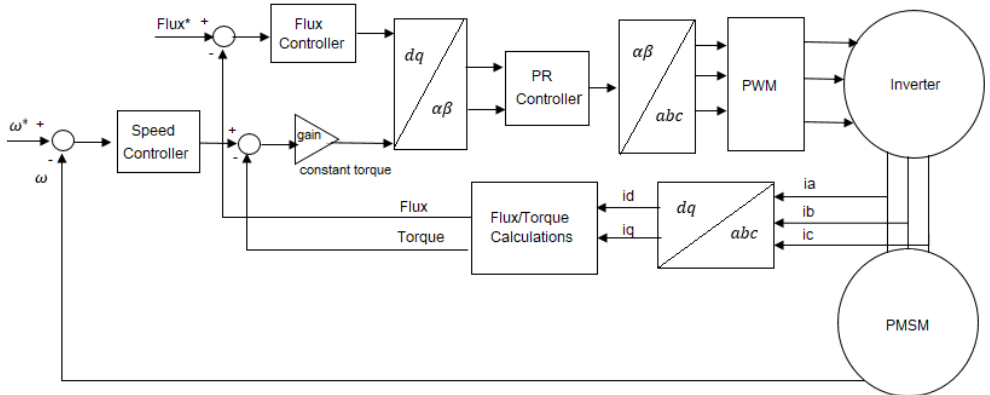
Figure 2. Block diagram of the proposed